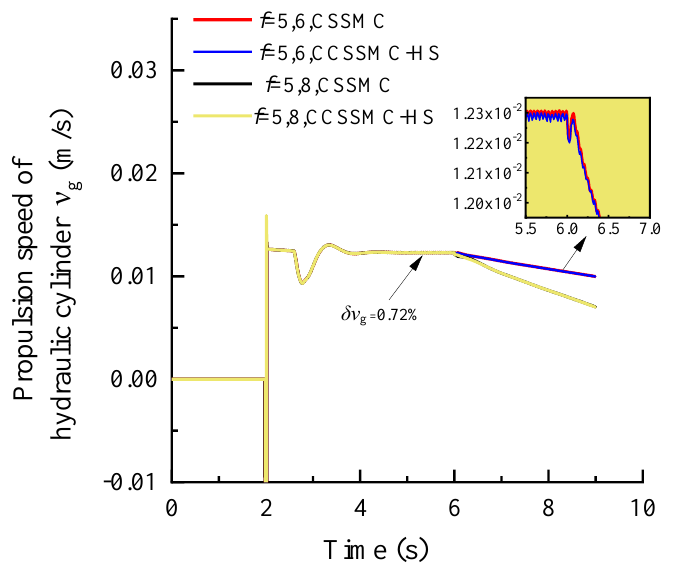
Figure 15. Variation curve of the hydraulic cylinder speed based on the CSSMC and CSSMC-HS. Figures 13–15 show that the change curve of each physical quantity of the hydraulic system based on the CSSMC-HS coincides with the curve based on the CSSMC. The relative deviation between the time when they enter the steady state and the pulsation coefficient under the steady state are both less than 2%. While the pump controlling the hydraulic system was based on the CSSMC (the rock hardness factor gradually changed from f = 5 to f = 8), the hydraulic pump outlet pressure overshoot was reduced from 11.19% to 7.97% compared with that before the optimization, which reduced the impact of the load change on the system stability.